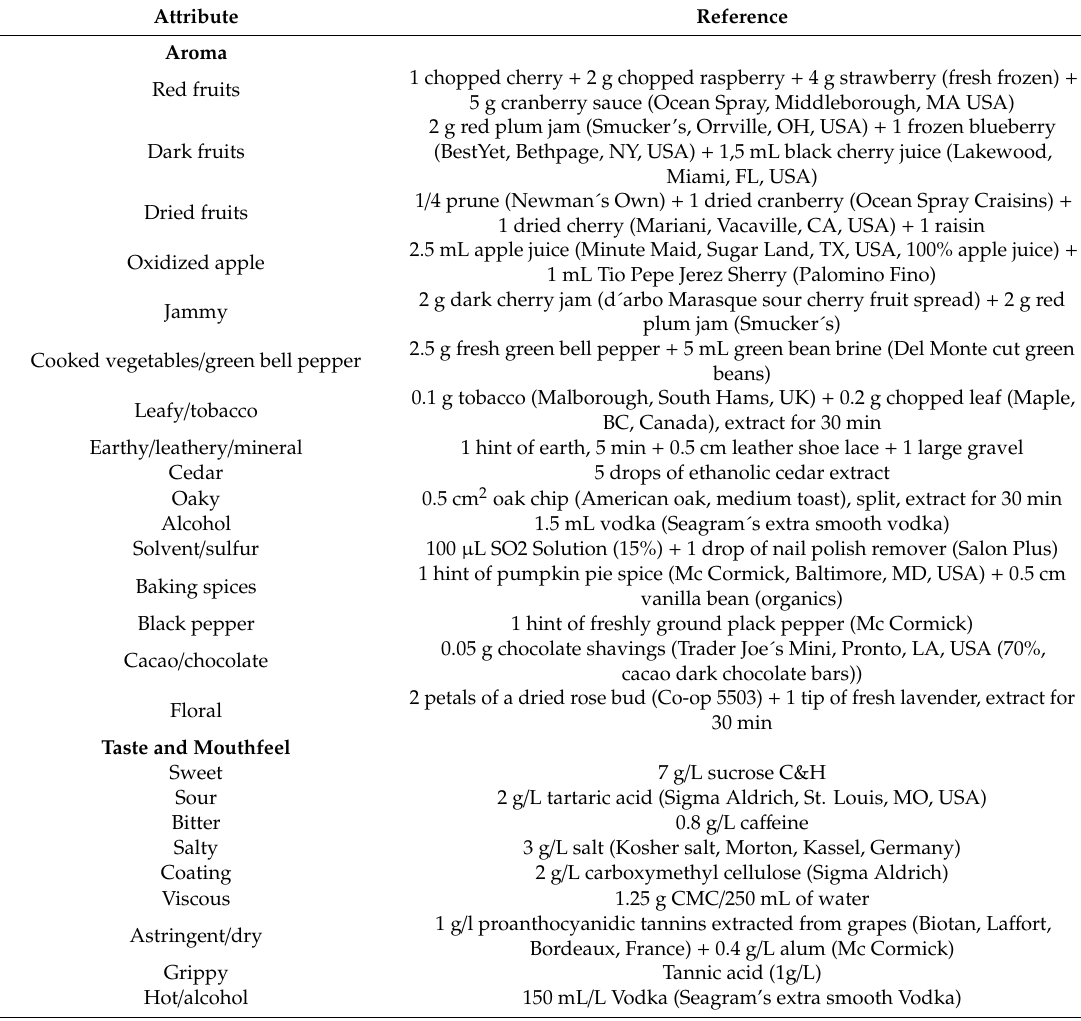
Table 8. Attributes used in the descriptive analysis (DA) and the corresponding reference standards in